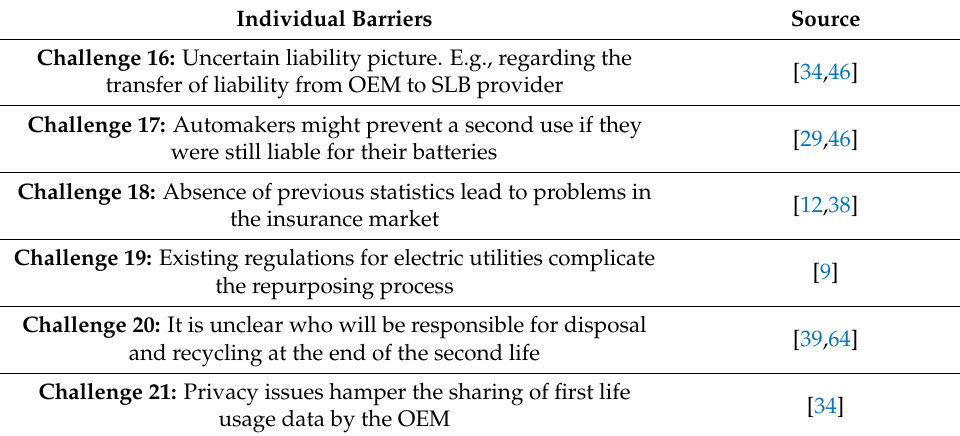
Table 5. The main legal barriers. Individual